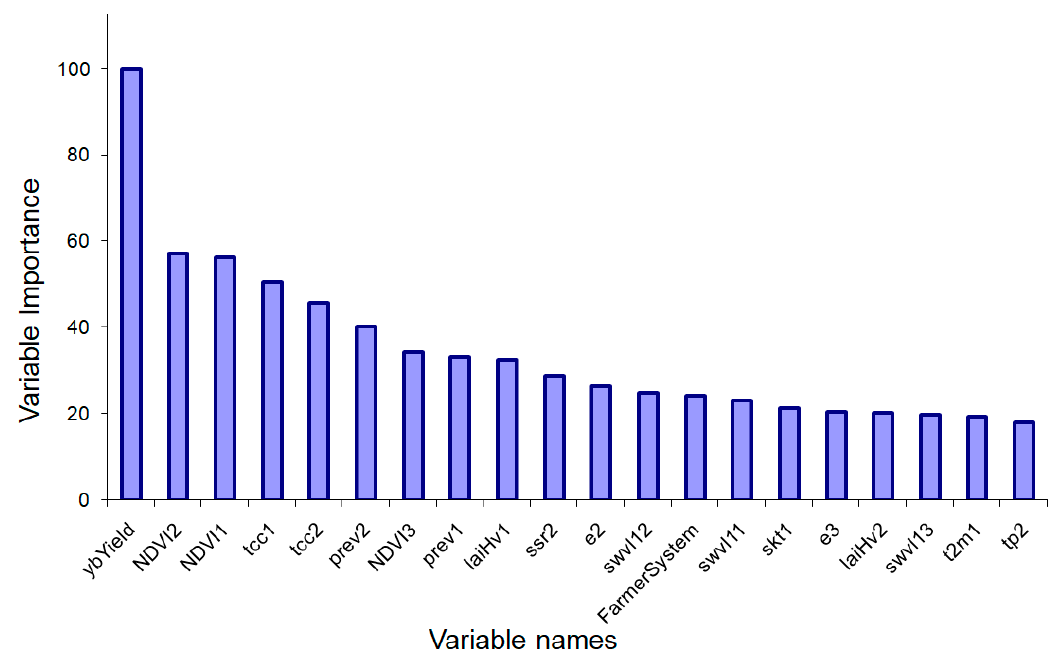
Figure 3. Variable importance of the rf model, 3-month scenario and winter cycle using bootstrapping method (25 repetitions) and one iteration.